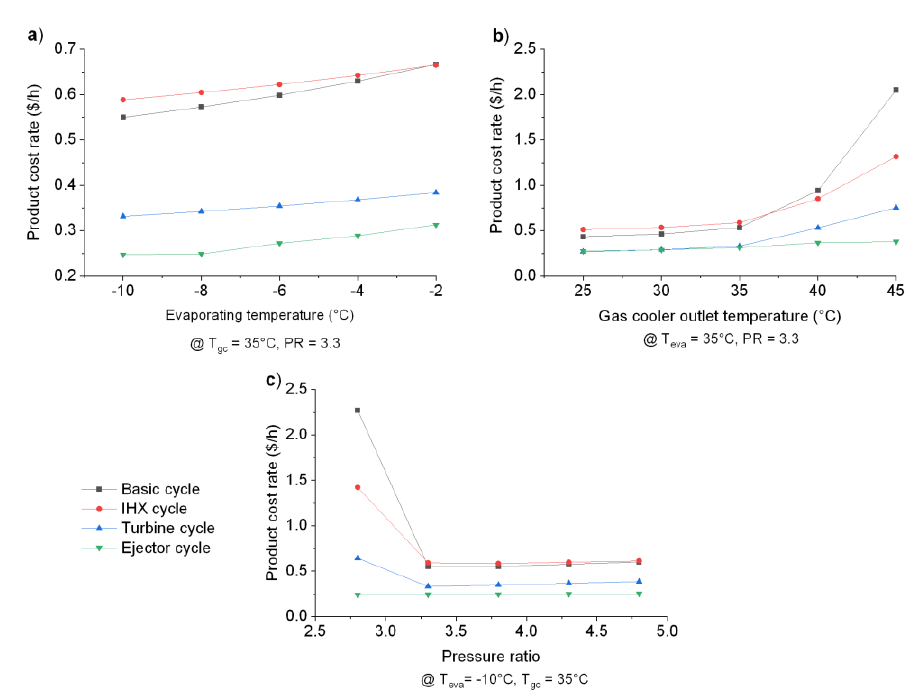
Figure 6. Variations in the product cost rate due to the: ( a ) evaporating temperature; ( b ) gas cooler outlet temperature; ( c ) pressure ratio.